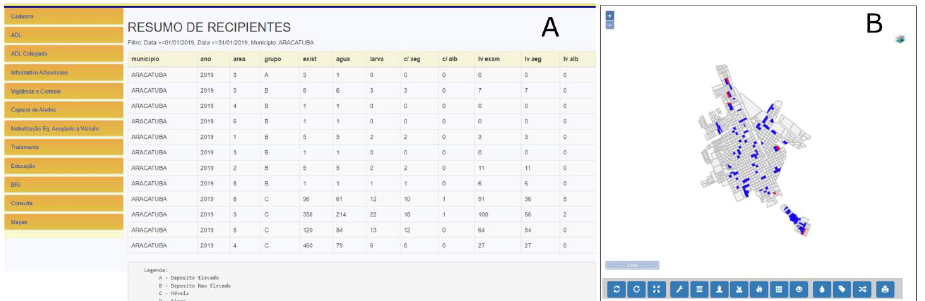
Figure 7 . ( A ) Analysis of the local situation in one county: Example summary per group of recipients per area in the city of Araçatuba, SP, Brazil; ( B ) Distribution of blocks with recipients and with re-